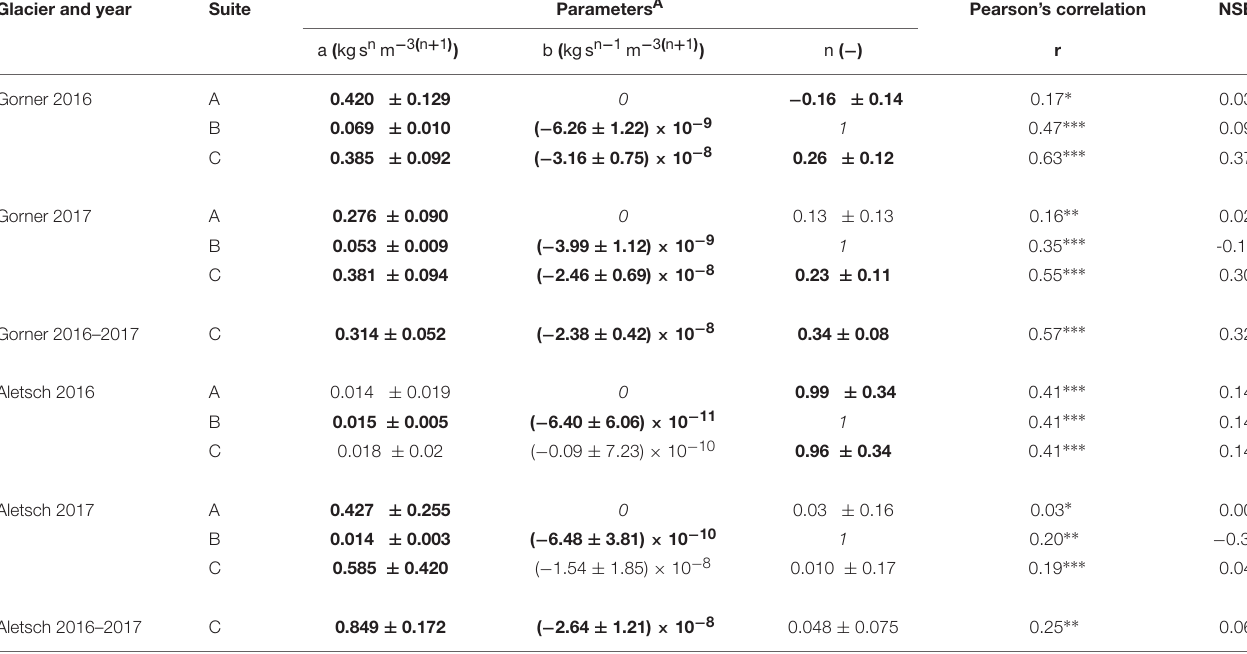
TABLE 2 | Fitted parameters and skill metrics of the empirical models presented in Section 3.3. Glacier and year Suite